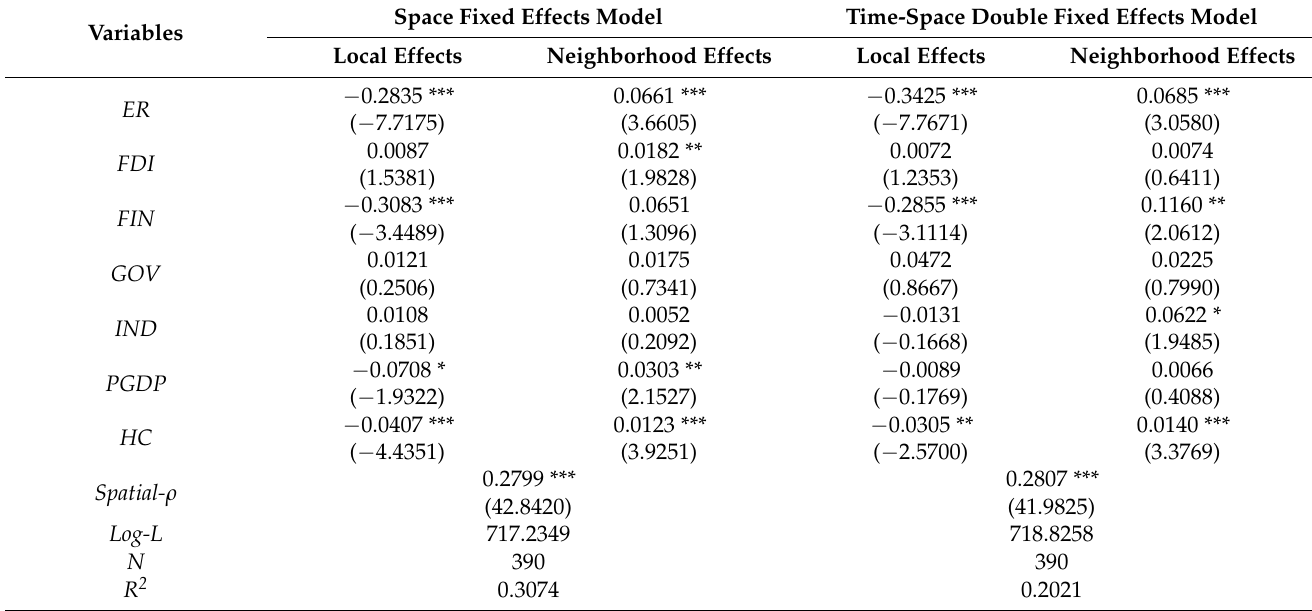
Table 7. Consequences of the “local neighborhood” effect of ER on polluting